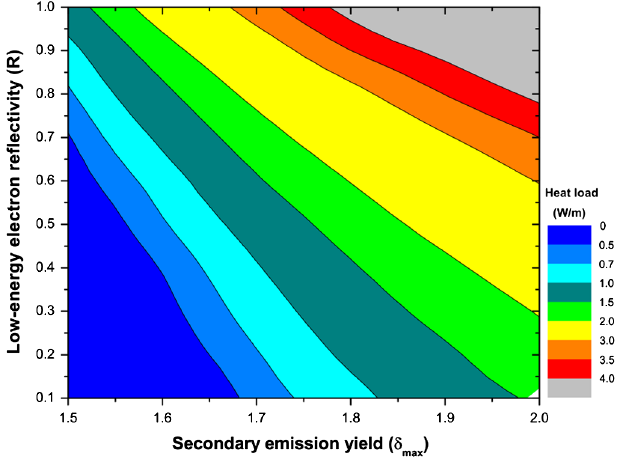
FIG. 11. Heat-load contour plot for 25 ns bunch spacing at 450